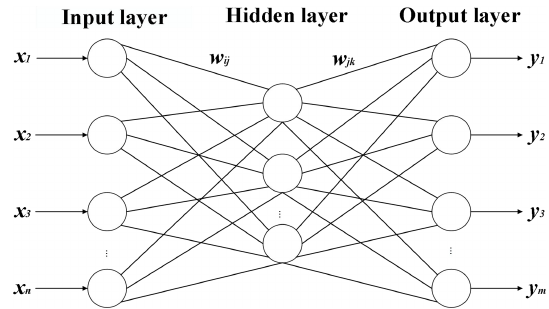
Figure 2. Three-layer BP neural-network